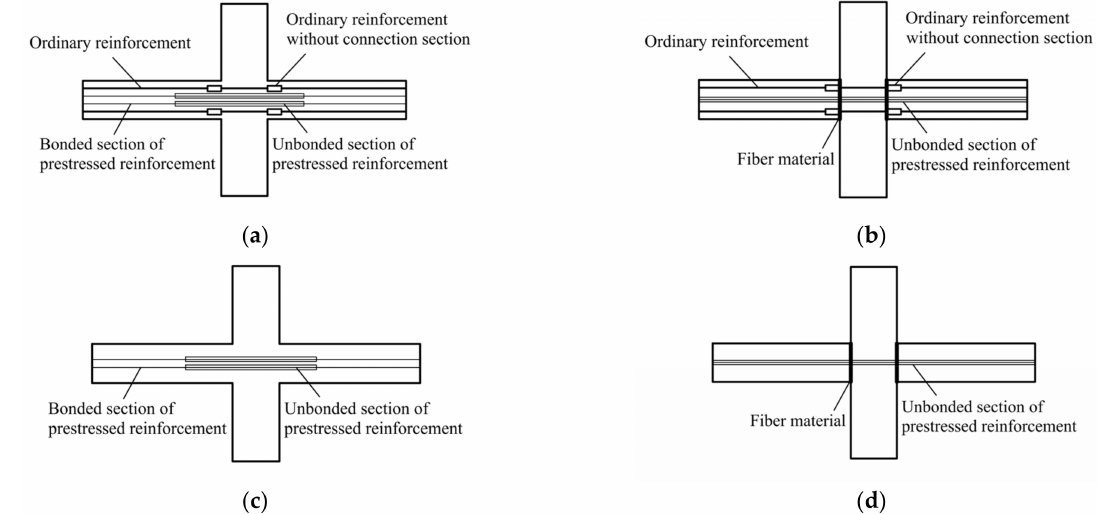
Figure 1. Four prestressed connection methods recommended by the PERSSS project [3]: ( a ) pre-tension with damping; ( b ) post-tension with damping; ( c ) pre-tension without damping; ( d ) post-tension without